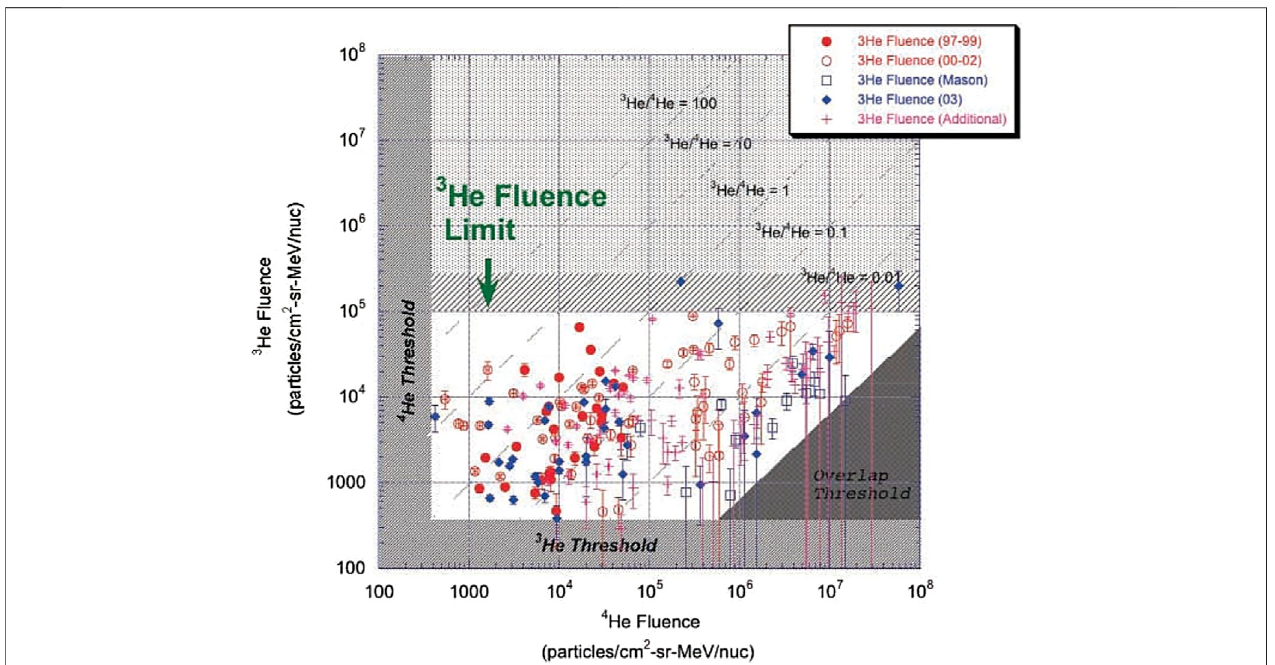
FIGURE 5 | Relative abundance of Helium isotopes accelerated in solar fl ares (Ho et al., 2005; Petrosian et al., 2009).